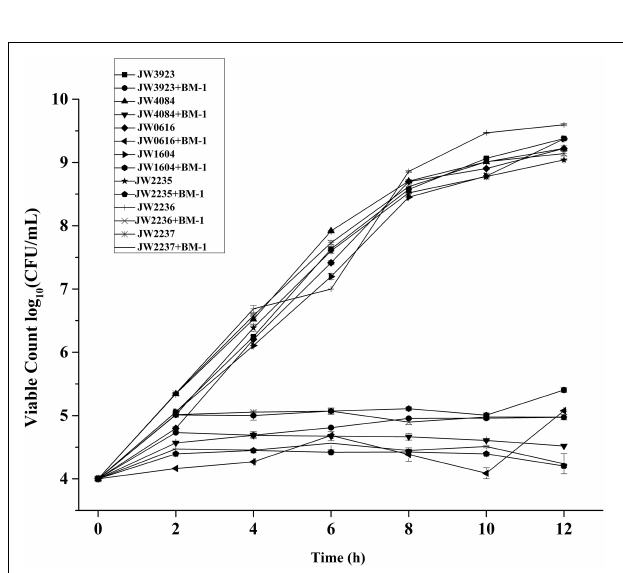
FIGURE 7 | Effects of plantaricin BM-1 on the growth of mutant E. coli JW3923( pflD ), E. coli JW4084( dcuB ), E. coli JW0616( dcuC ), E. coli JW1604( fumA ), E. coli JW2235( glpA ), E. coli JW2236( glpB ), and E. coli JW2237( glpC )